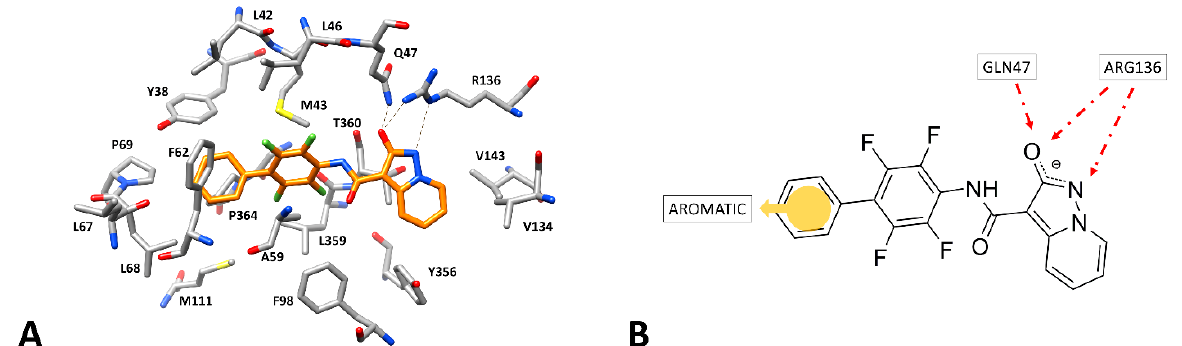
Figure 2. Hydroxypyrazolo[1,5-a]pyridine inhibitor MEDS433 within the binding site of h DHODH (PDB code: 6FMD). ( A ) The ligand (orange) is surrounded by the protein residues that constitute the binding site (shown as gray sticks), while the hydrogen bonds are shown as black dashed lines. ( B ) Receptor-based pharmacophore model with the four features superimposed to the h DHODH inhibitor